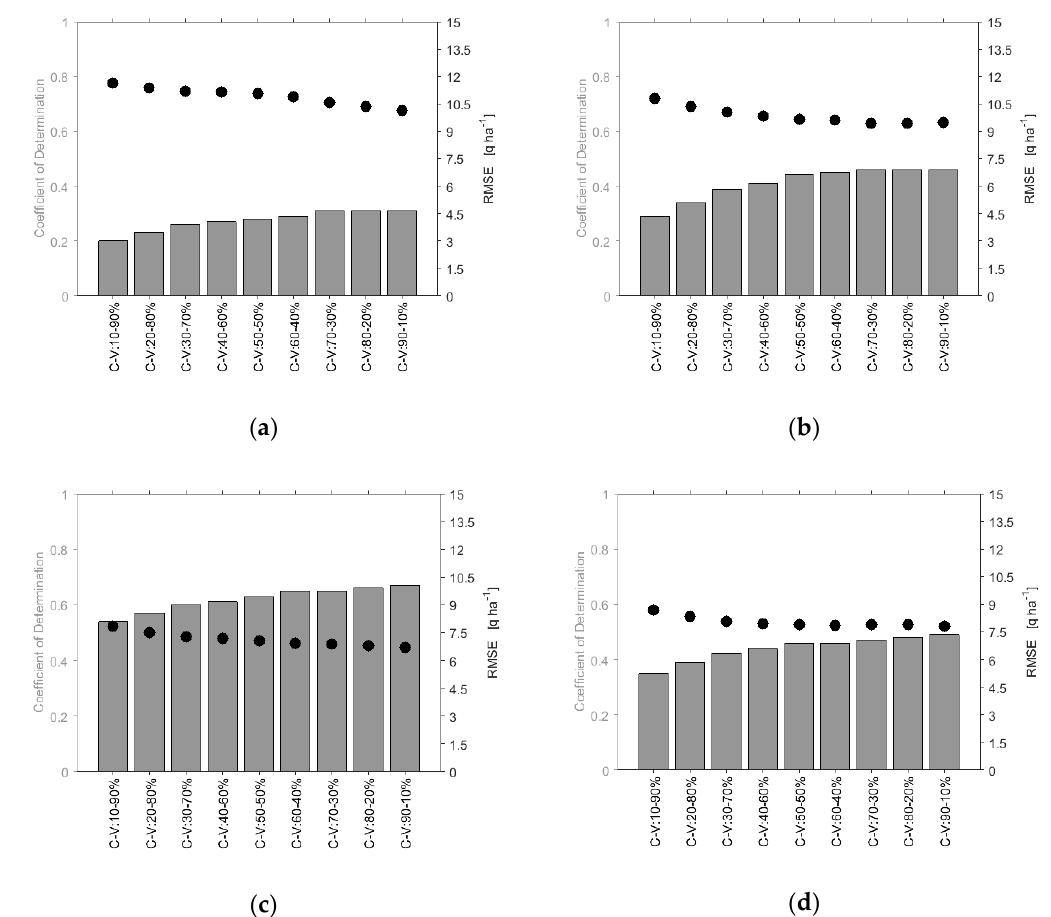
Figure 2. Statistical performance (coefficients of determination and root mean square errors, bars and dots, respectively) associated with the estimation of the wheat yields (considering multi-temporal Normalized Difference Vegetation Index (NDVI) as input variable) as a function of the ratios of training and validation data, for the years 2014 ( a ), 2015 ( b ), 2016 ( c ) and 2017 ( d ).